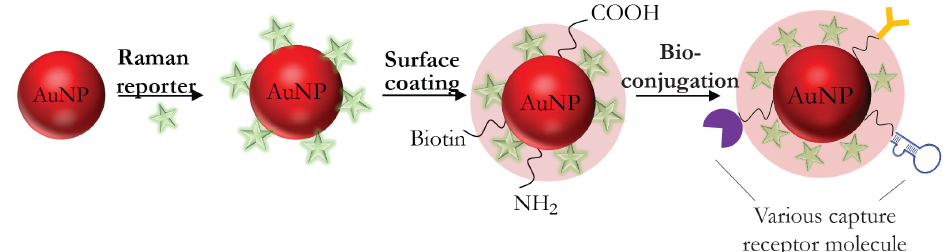
Figure 4. Design of SERS nanotag consisting of a metal nanoparticle core, modified by reporter mol- ecule (green stars), protected by biocompatible layer (pink shell), and functionalized by a capture receptor molecule.